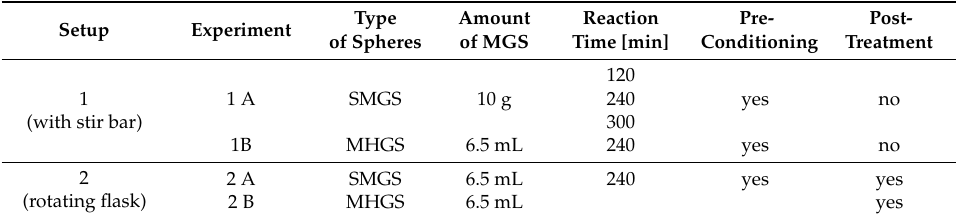
Table 3. Parameters of the individual coating experiments. Setup Experiment